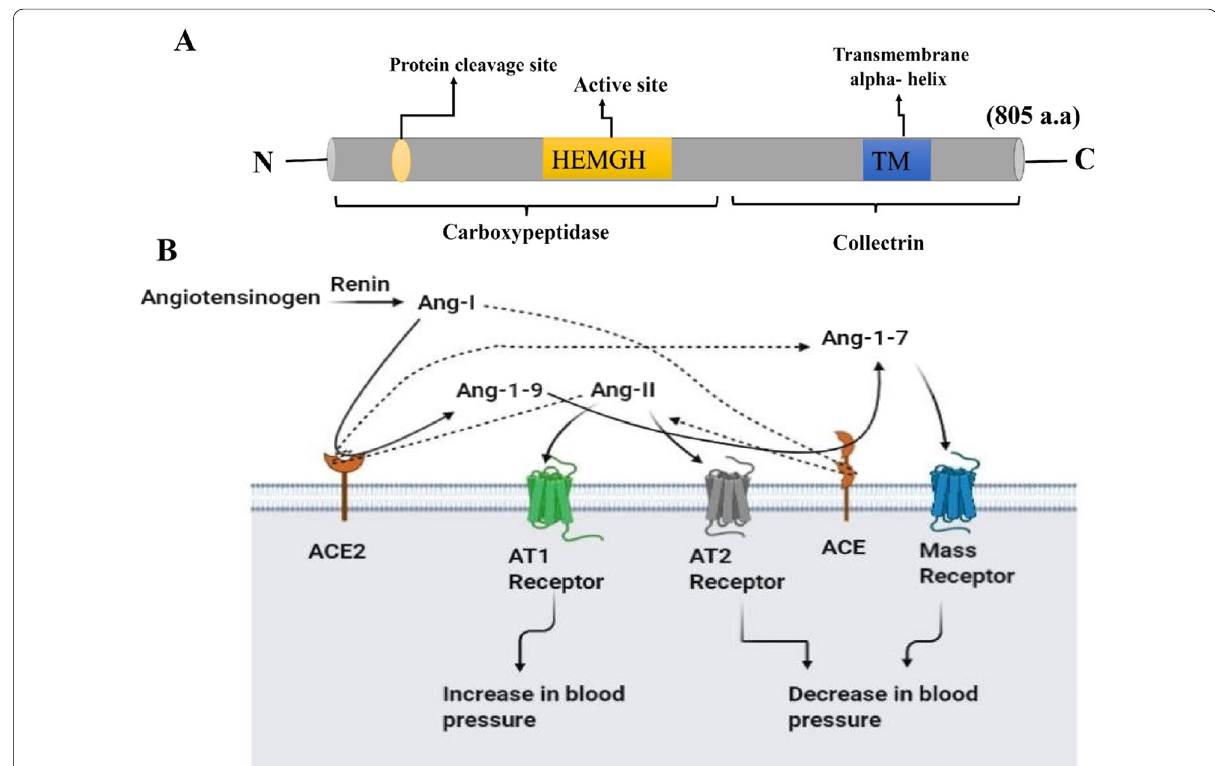
Fig. 2 ACE2 structure and its function in the renin–angiotensin–aldosterone system (RAAS). A ACE2 structure; N-terminal domain includes single peptide, protein cleavage site, and active site and C-terminal domain contain transmembrane alpha-helix. B Schematic overview of ACE2 functions in the renin–angiotensin–aldosterone system